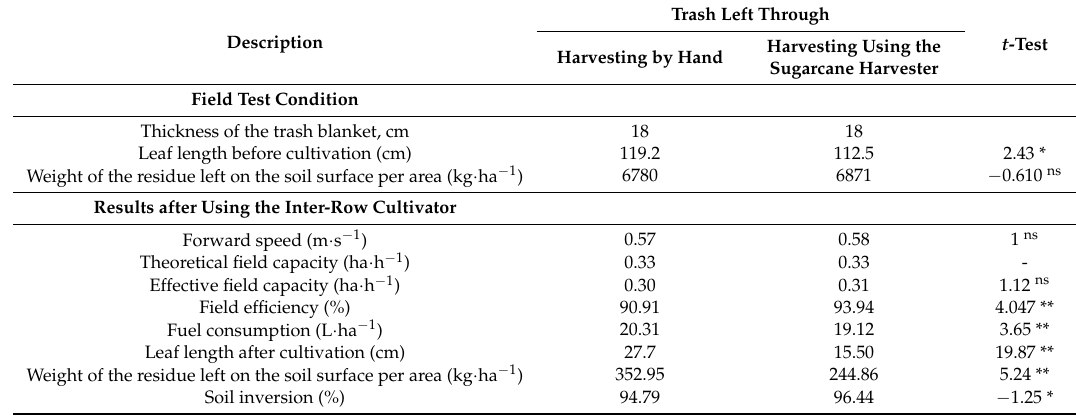
Table 3. The performance test and the practical field test of an inter-row cultivator attached to the 37.3-kW tractor.